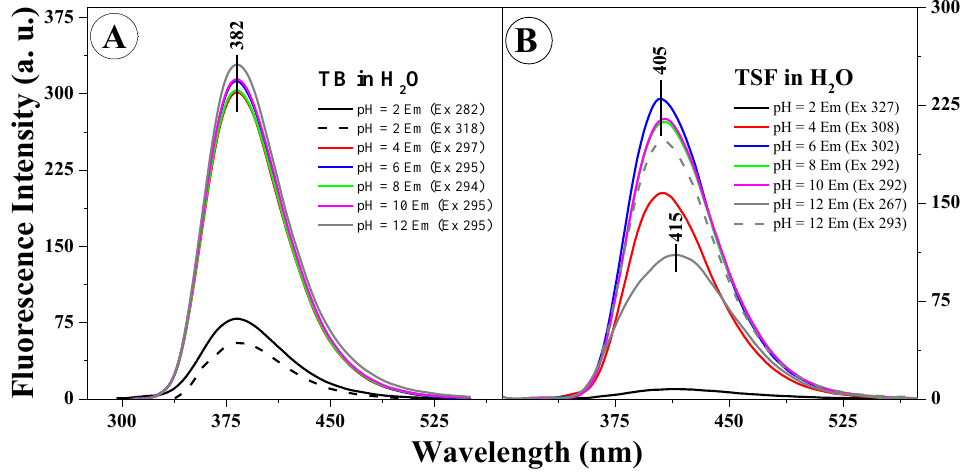
Figure 3. Fluorescence emission spectra of ( A ) TB and ( B ) TSF dissolved in H 2 O at different pH. The excitation was set at the absorbance maximum of each sample, respectively, as pointed out in the figure. The spectra were measured at room temperature.